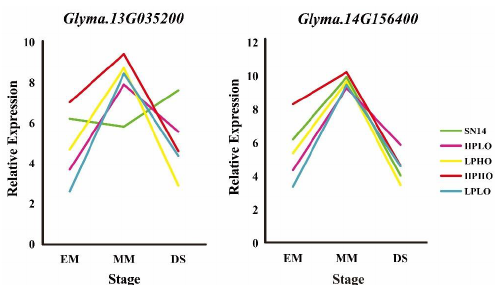
Figure 7. Expression analysis of miRNA targeting genes. The X -axis represents the developmental stage of the seed, and the Y -axis represents the relative expression level. Different colored lines represent different materials.